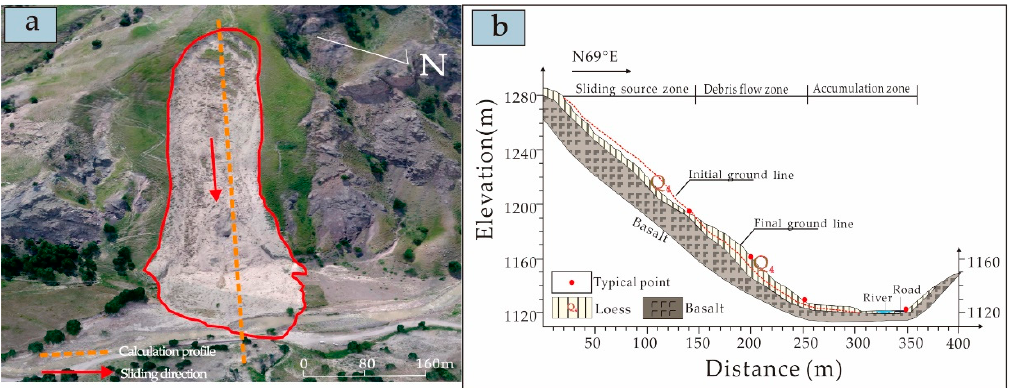
Figure 4. ( a ) Overview of the Panjinbulake landslide. ( b ) The engineering geological section.